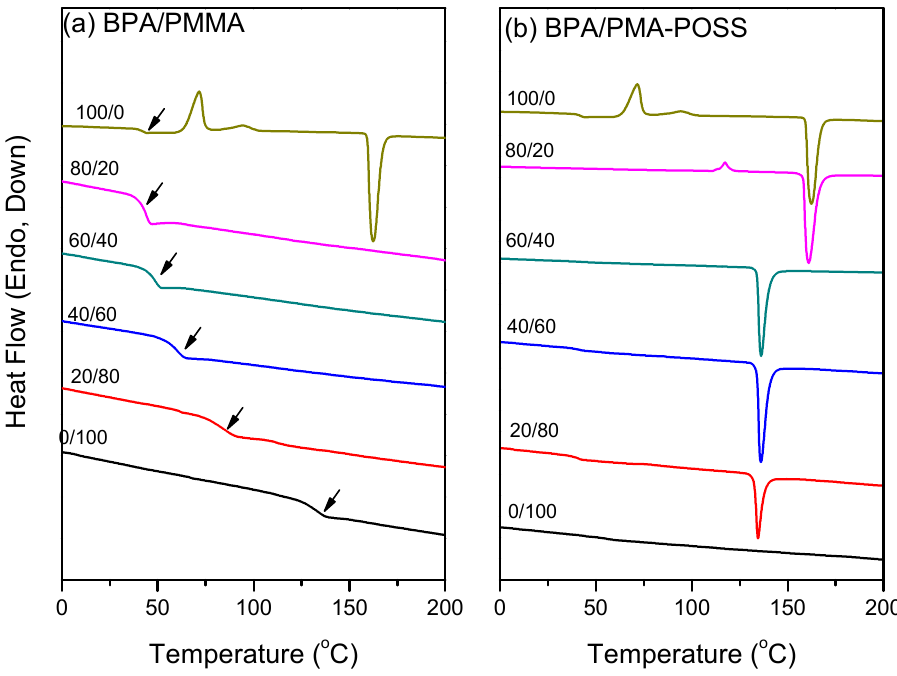
Figure 5. DSC thermograms of ( a ) PMMA and ( b ) PMA-POSS blends containing various BPA compositions (weight